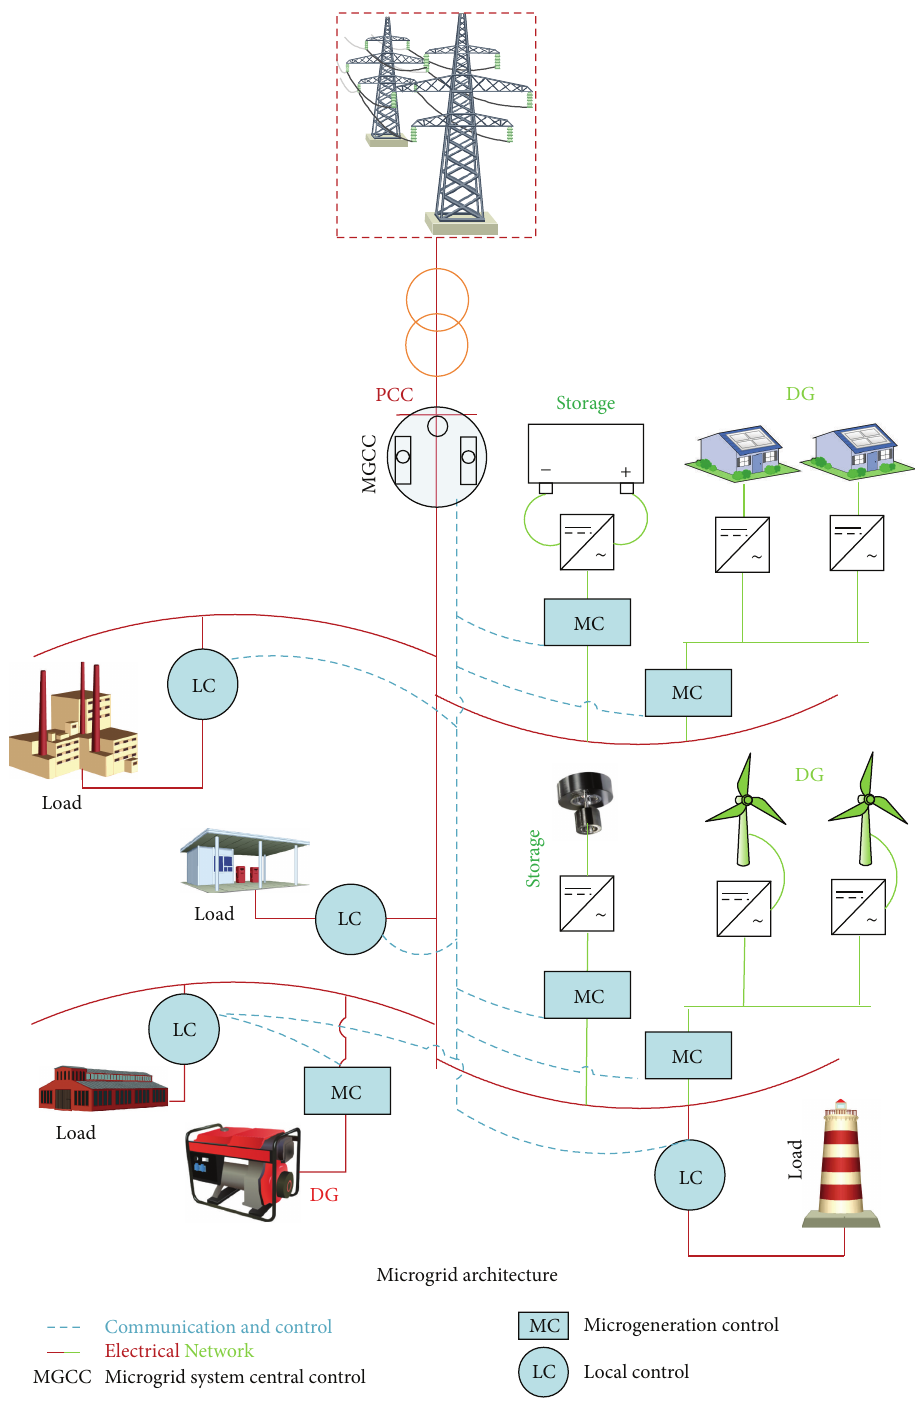
Figure 1: A simple microgrid